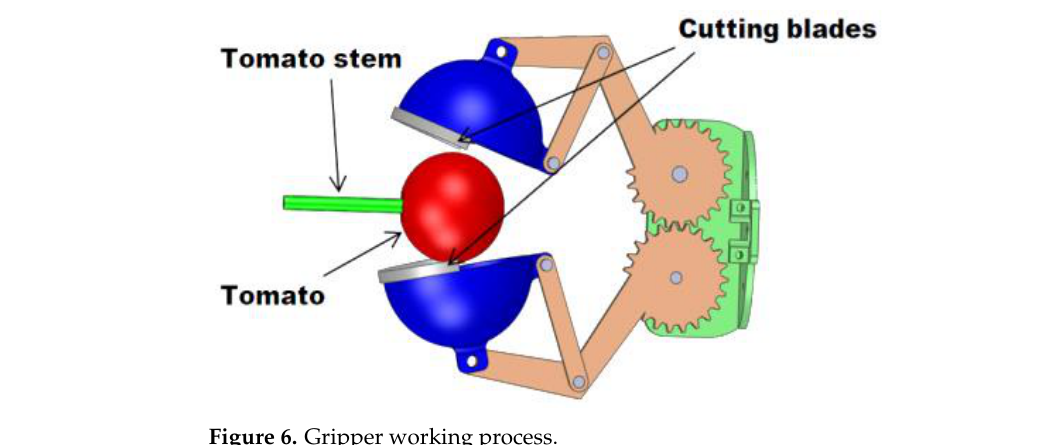
Figure 5. ( a ) Gripper CAD design and ( b ) Fabricated prototype.